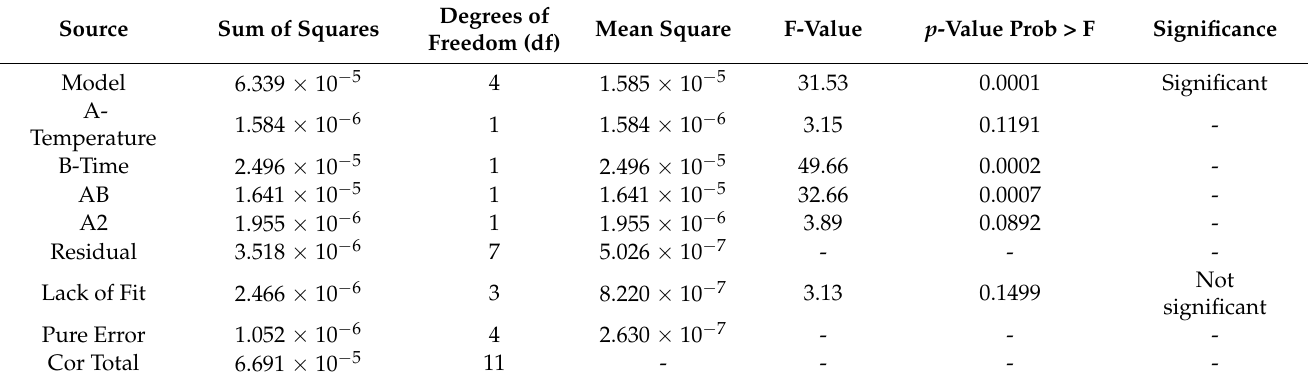
Table 6. The ANOVA table for the average WSD of the MoS 2 nanolubricants.